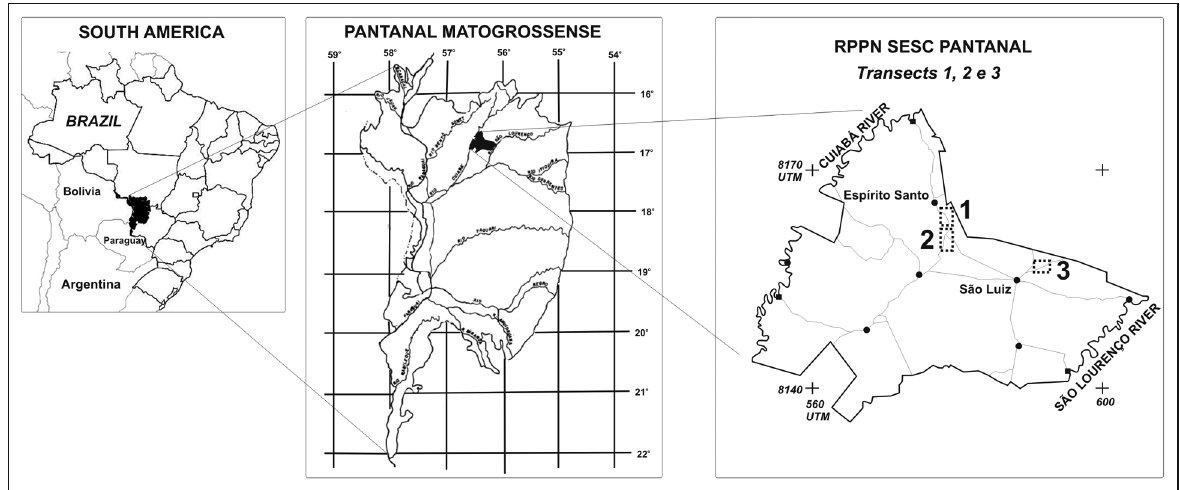
Figure 1 - Localization of Pantanal Matogrossense, RPPN SESC Pantanal and transects (1, 2 and 3), Barão de Melgaço, Mato Grosso,